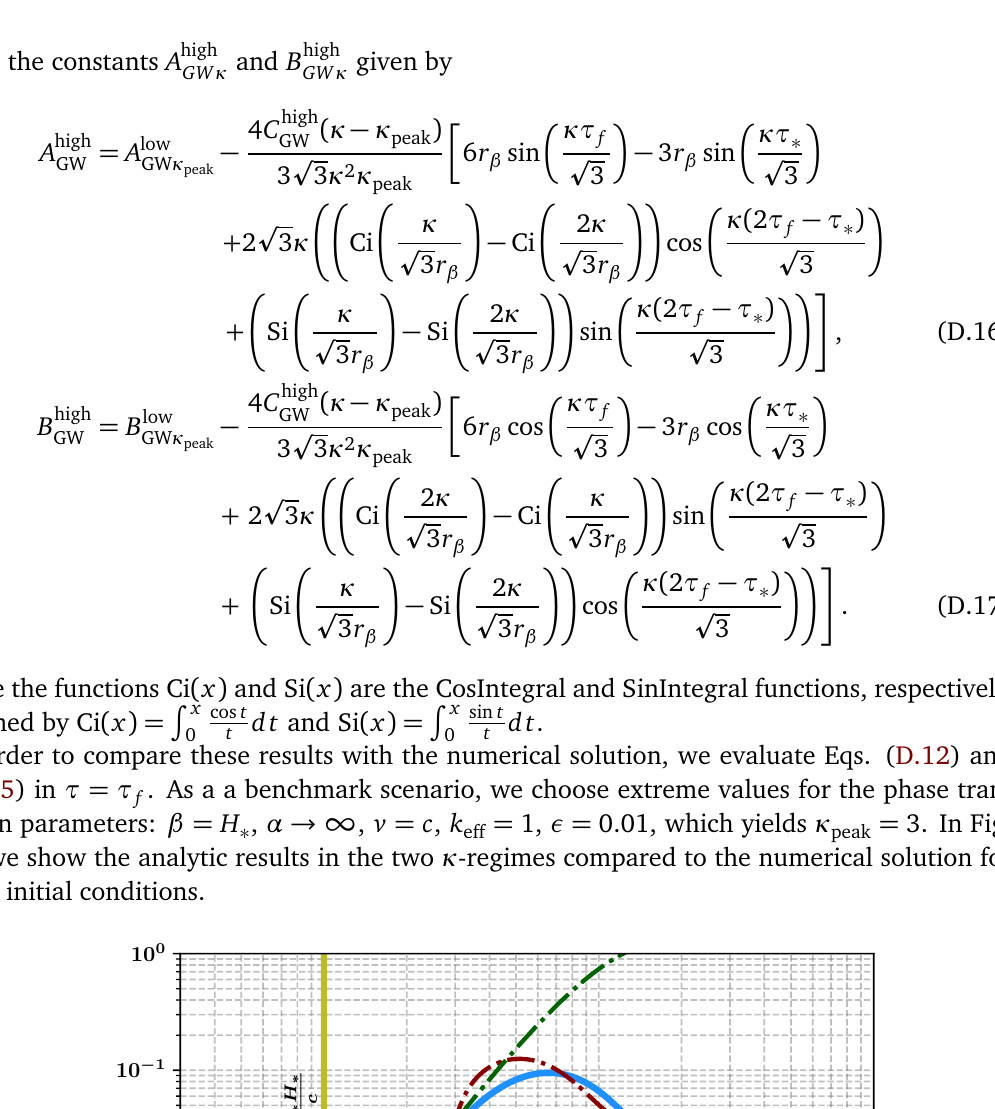
in the low- and high κ limit with the full f